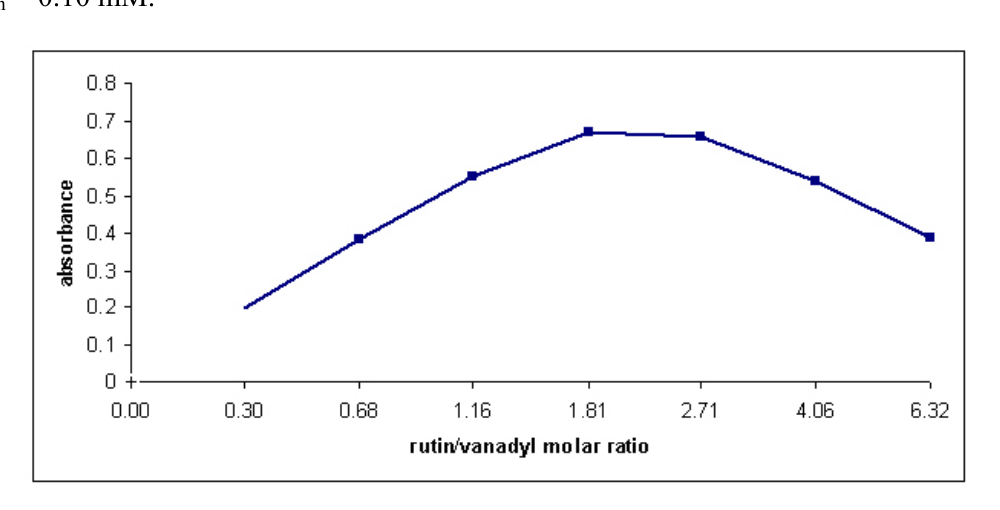
Figure 9. Plot of the VO 2+ -rutin complex formation in aqueous solution (pH 6); C VO2+ + = 0.10 C rutin